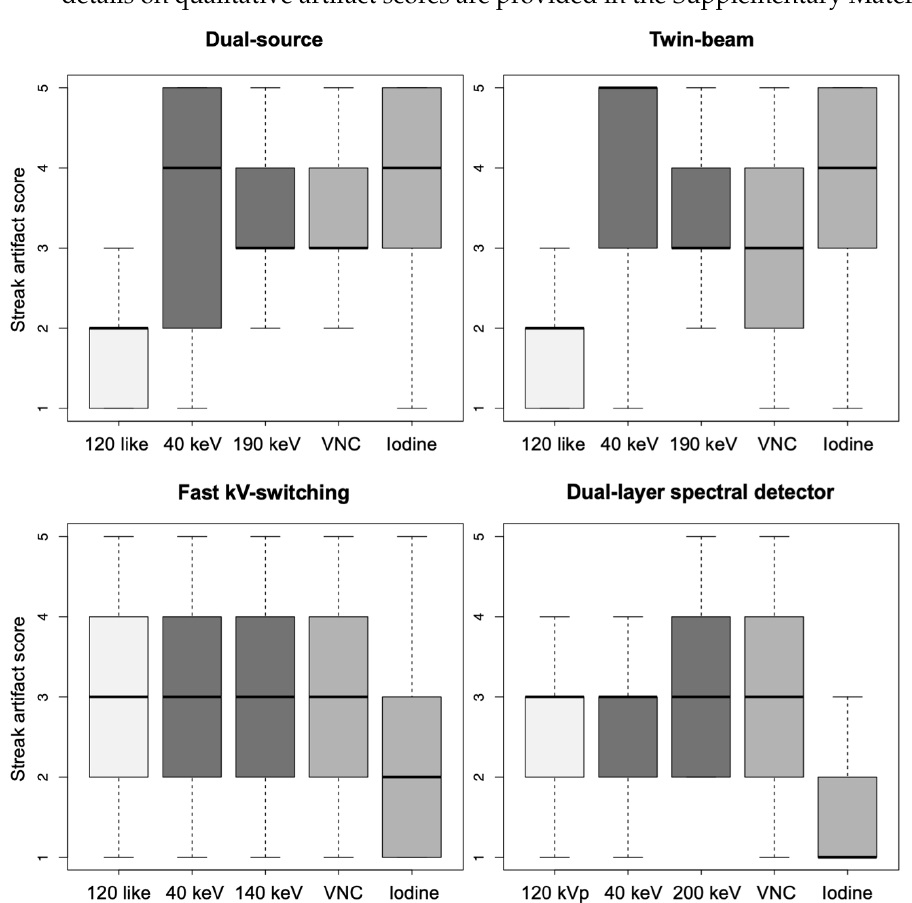
Figure 4. Qualitative artifact scores (1 = none to 5 = severe) of visceral-motion-related artifacts on the liver in axial 120-kVp(-like), low- and high-keV, VNC, and iodine images acquired on a dual- source, twin-beam, fast kV-switching, and dual-layer spectral detector CT